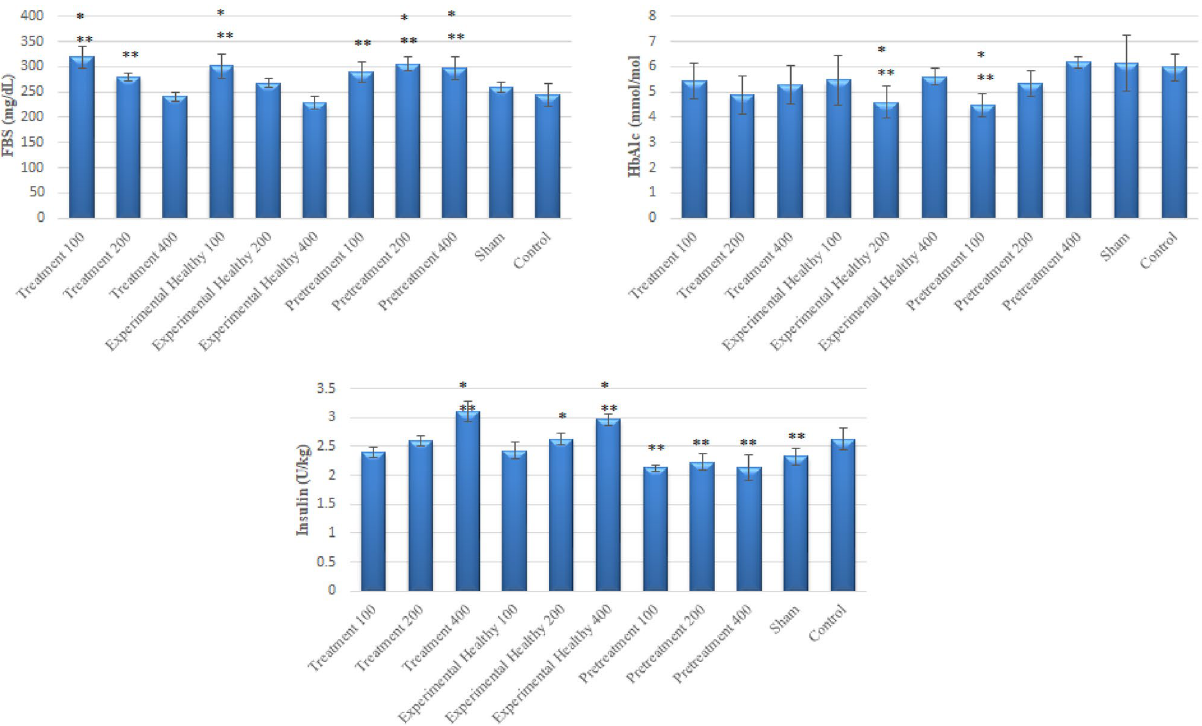
Figure 1. The effect of S. striata extracts on Insulin, FBS and HbA1c. Data are expressed as the mean ± SD; n = 6 for each group. 100, S. striata 100 mg/kg bw; 200 , S. striata 200 mg/kg bw; 400, S. striata 400 mg/kg bw. Significant differences compared to the Sham and Control groups were shown P ≤ 0.05 *, and P ≤ 0.05**, respectively. ANOVA and Tukey’s were applied to evaluate the